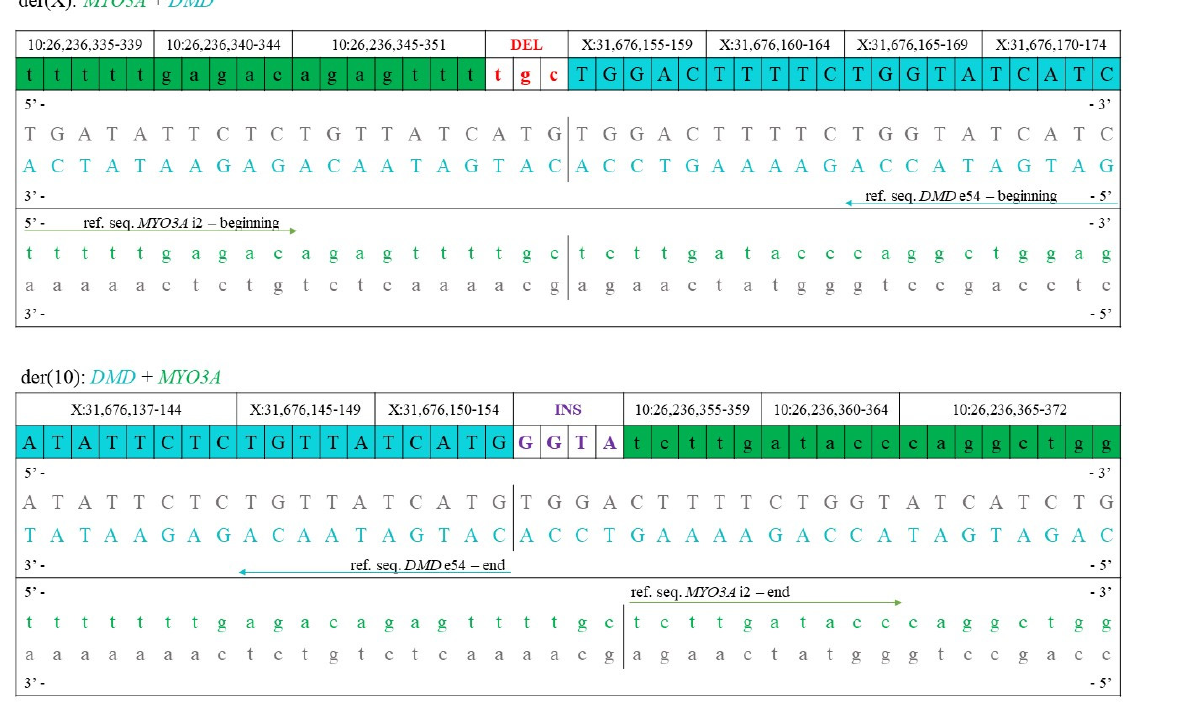
Figure 6. Representation of the der(X) and der(10) chromosome sequences at the breakpoints showing that there is a 3bp (TGC) deletion (DEL) on the der(X) chromosome and a 4bp (GGTA) insertion (INS) on the der(10) chromosome.